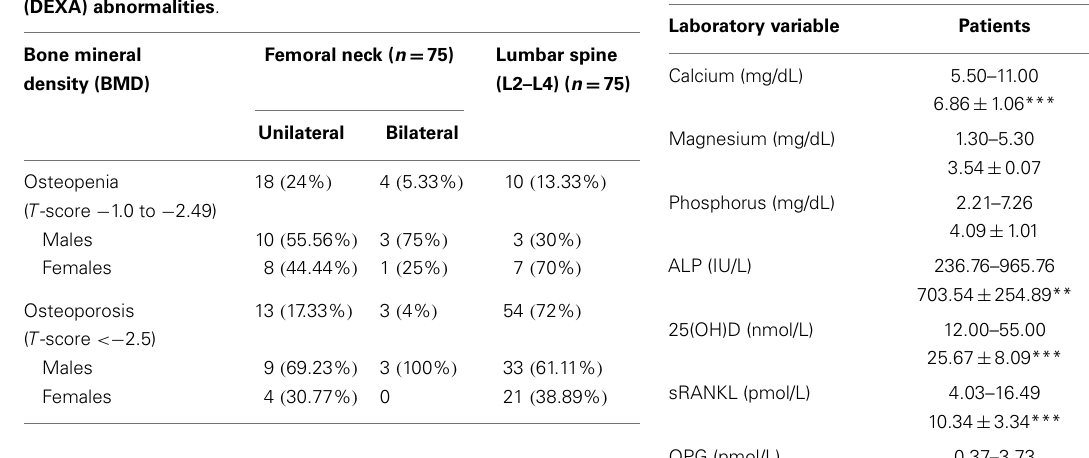
Table 4 | Laboratory results of the studied groups .